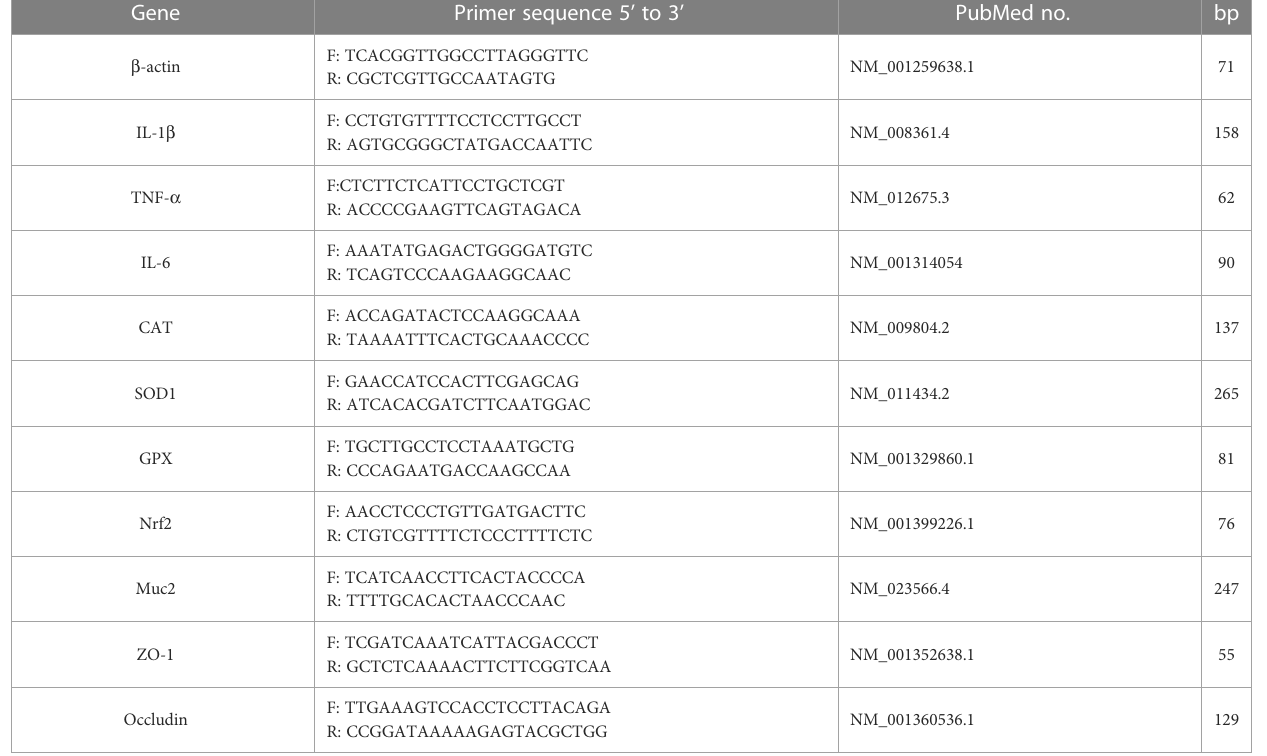
TABLE 1 primer sequences for